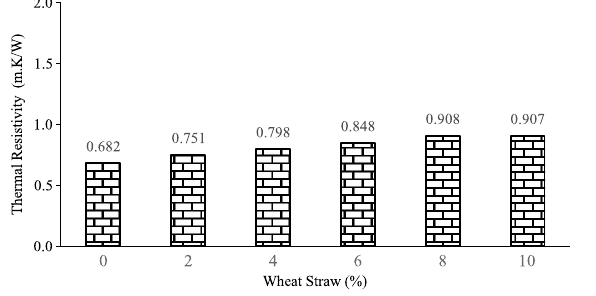
FIG. 9. EFFECT OF WHEAT STRAW ON THE THERMAL RESISTIVITY TABLE 4. EFFECT OF LIME CONTENT ON THERMAL CONDUCTIVITY/